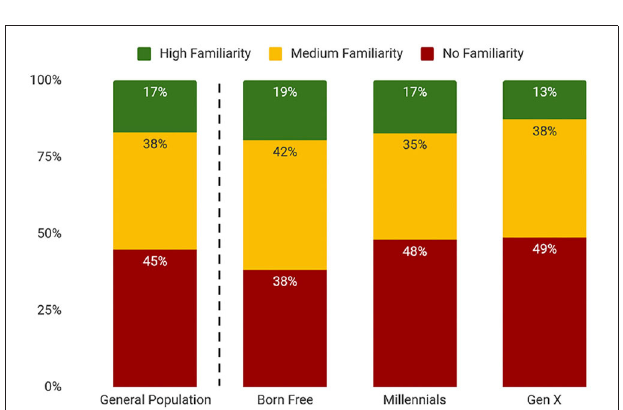
FIGURE 4 | Future adoption of plant-based meat in the general population.